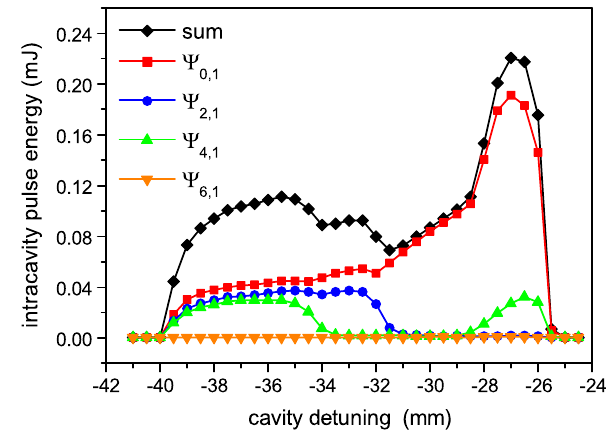
FIG. 3. Intracavity pulse energy as well as energy of most active Ψ modes as function of the cavity detuning at z m; 1